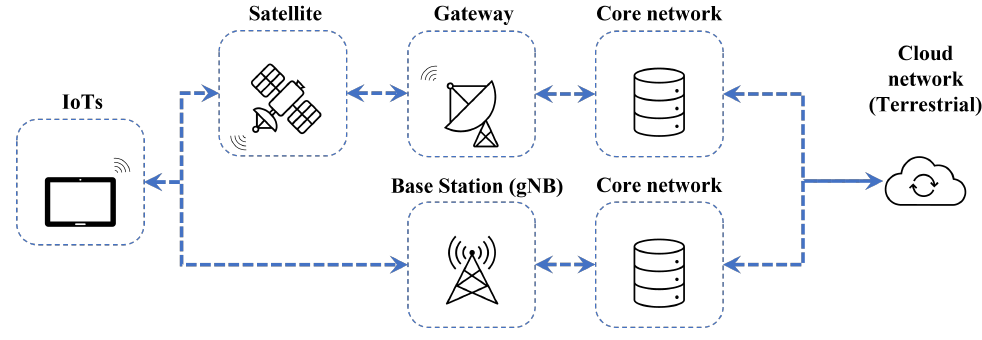
Figure 2. Illustration of the hybrid IoT-over-Satellite network